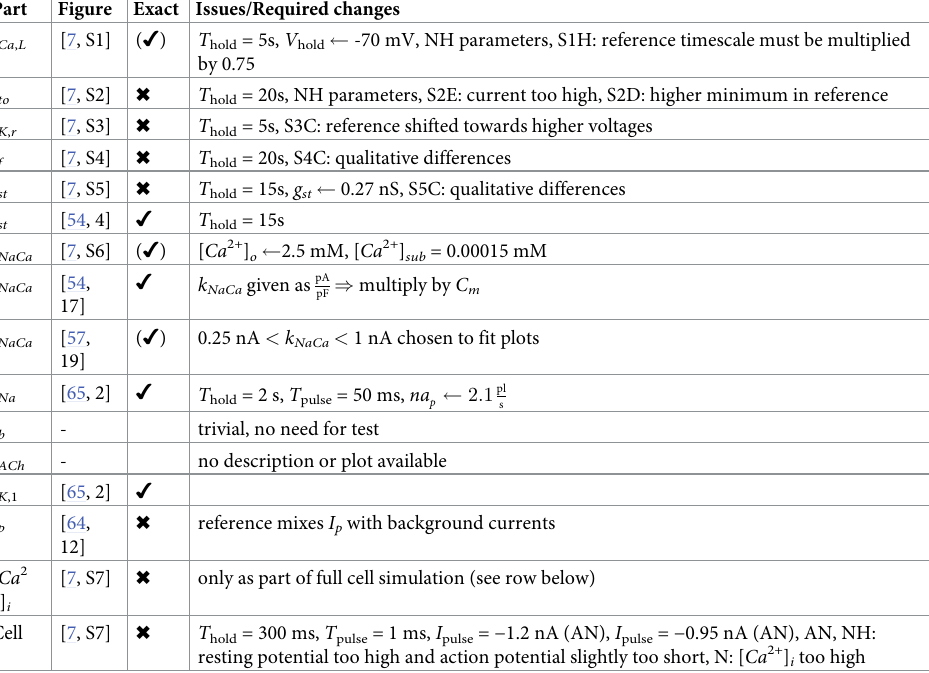
Table 4. Summary of individual experiments that were reproduced with InaMo. Part Figure Exact Issues/Required